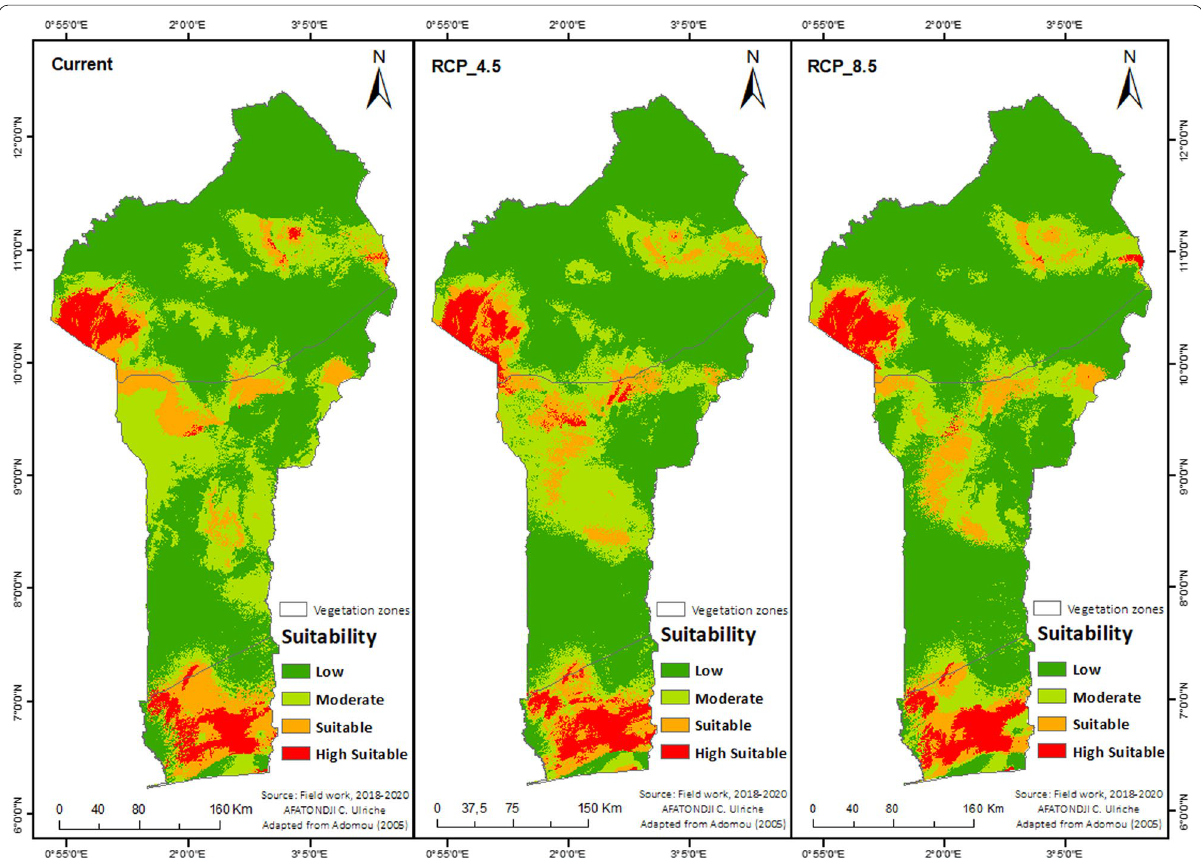
Fig. 10 Map of current and future potential suitable habitats for Goat Type III under RCP 4.5 and RCP 8.5 across Benin. RCPs 4.5 and 8.5 are climate scenarios of 4.5 W m − 2 and 8.5 W m − 2 ,